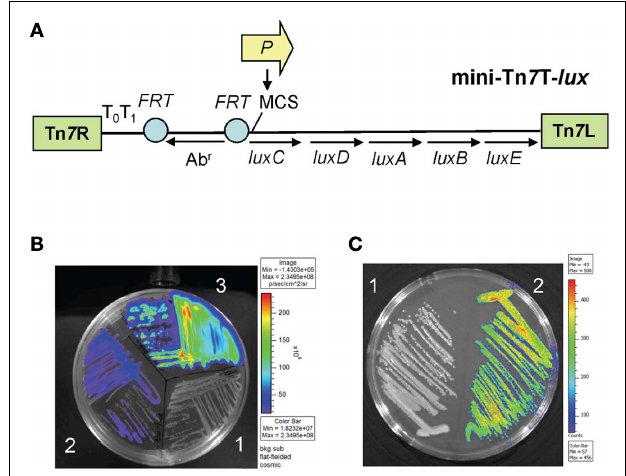
FIGURE 7 | Bioluminescent tagging of Burkholderia spp. with mini-Tn 7-lux elements. (A) Map of a typical mini-Tn 7 - lux element.The basic element contains a promoter-less P. luminescens luxCDABE operon that is preceded by a multiple cloning site (MCS). An antibiotic resistance (Ab r ) selection marker inserted upstream of the lux operon is preferably flanked by yeast Flp recombinase target ( FRT ) sites that allow optional site-specific excision of the Ab r marker after site-specific insertion into the bacterial chromosome. Restriction sites in the MCS can also be used to insert customized promoter sequences (arrow labeled P ). (B) A mini-Tn 7 - lux element with a zeocin resistance selection marker was inserted into the glmS1 -associated insertion site of chromosome 1 of B. thailandensis strain E264 (Choi et al., 2005). Bacteria containing either no insertion (1), a promoter-less mini-Tn 7 - lux (2) or a mini-Tn 7 - P1 - lux element where the lux operon is transcribed from the strong P1 integron promoter (DeShazer and Woods, 1996) were grown overnight on an LB plate and imaged on an IVIS Spectrum imaging system. (C) A mini-Tn 7 - lux element with a